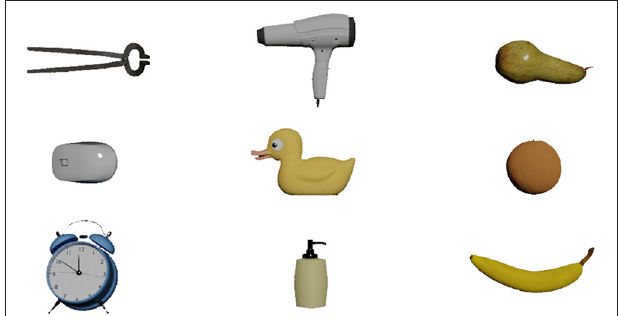
FIGURE 1 | Nine example 3D household objects from the freely available OpenVirtualObjects (OVO). (https://edmond.mpdl.mpg.de/imeji/collection/